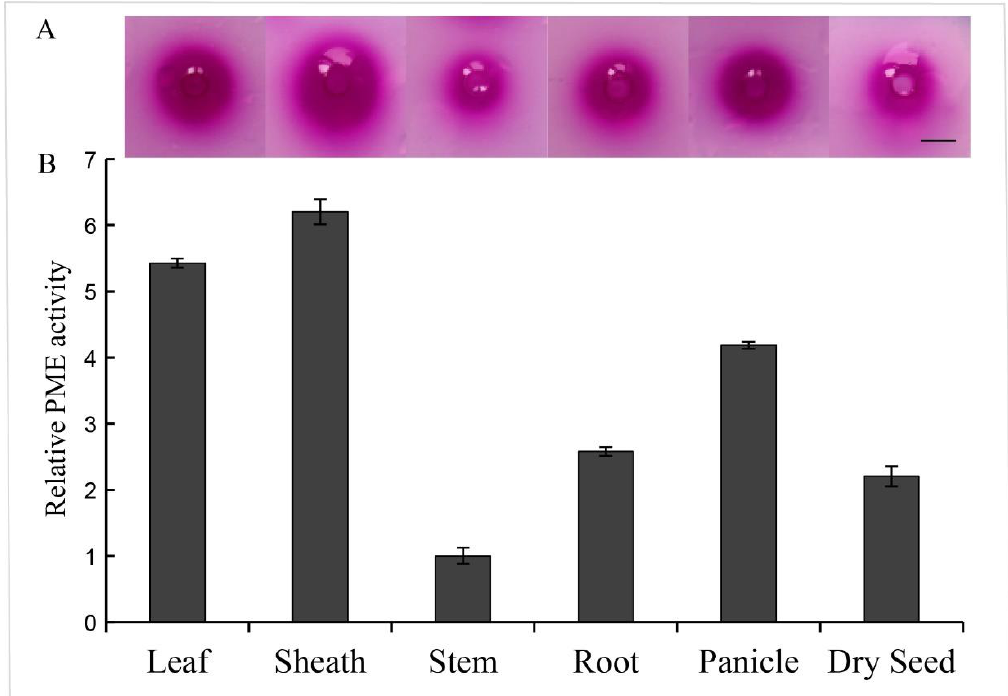
Figure 1. Relative pectin methylesterase (PME) activity analysis of six sorghum tissues. Total protein was extracted from six tissues of sorghum to analyze the PME activity. ( A ) Stained gels of the PME reaction using ruthenium red, the red halo means the de-methylesterificated pectin by PME. Scale bar = 0.5 cm. ( B ) The relative PME activity with the tissue stem area set to one, based on the halo area of stained gel.